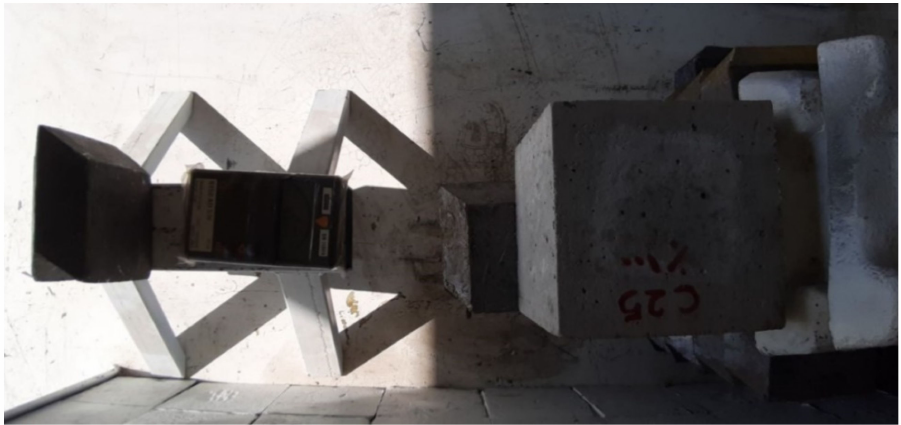
Figure 7. Gamma-ray transmission measurement test setup in the